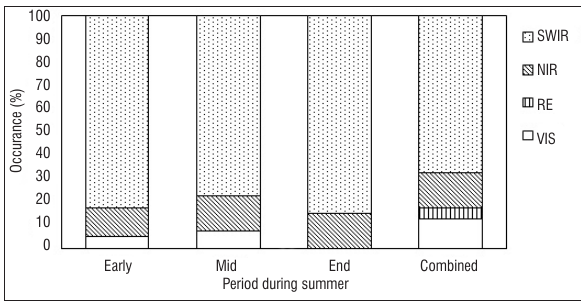
Figure 5: Summary of predictive bands of leaf area index in different spectral